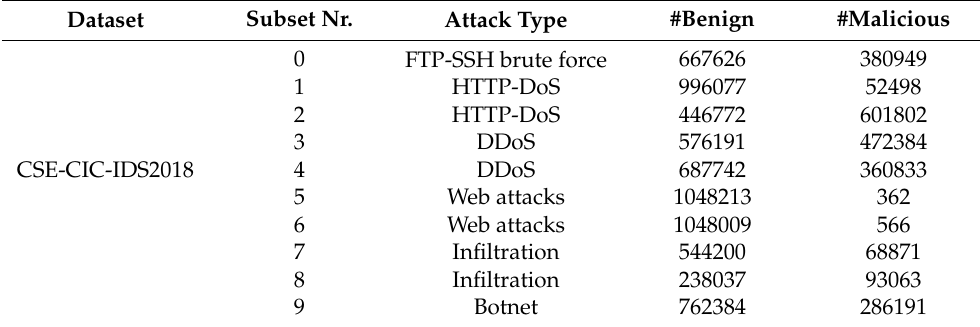
Table 3. CSE-CIC-IDS2018 Class Label